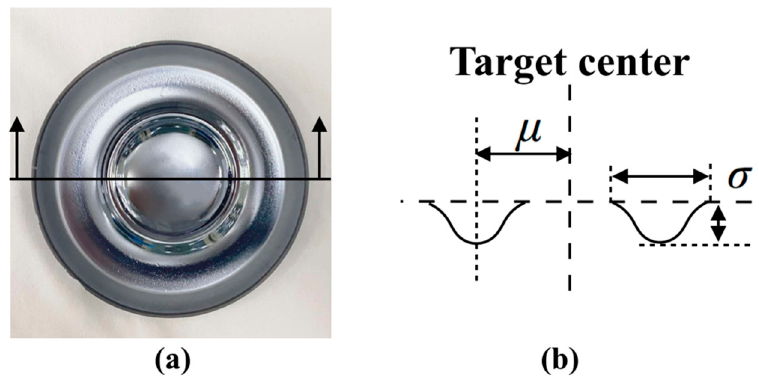
Figure 2. ( a ) Photo of the circular target. ( b ) Cross-section of the target, where μ is determined by the radius of the etched ring, and σ is related to the depth and width of the etched ring.